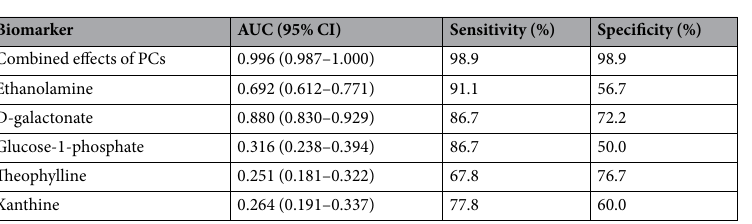
Table 5. Prediction performance of potential metabolic biomarkers between early-stage NSCLC and HC.